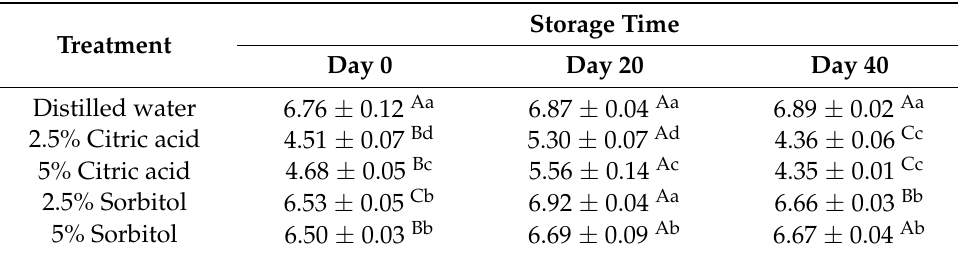
Table 3. pH of frozen fish fillets soaked with different solutions after thawing during frozen stor- age